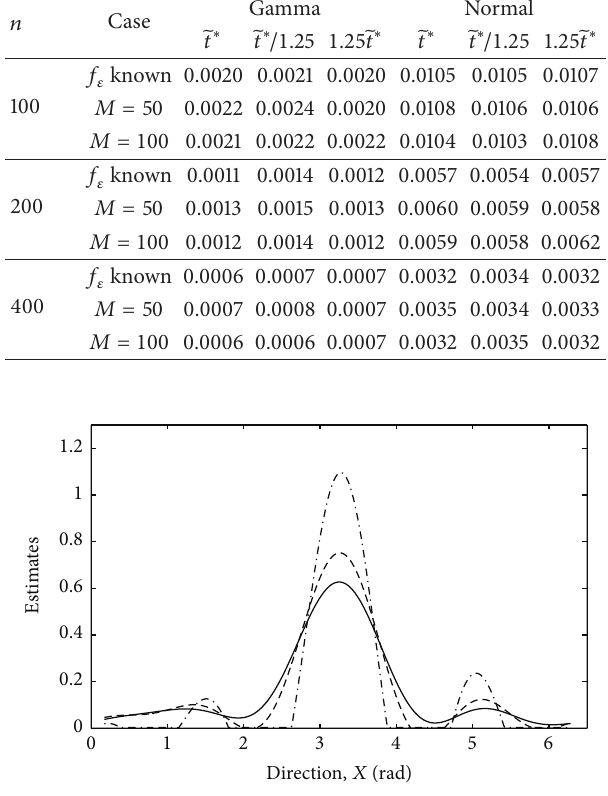
Figure 3: Estimates of density of movement of ants. The solid line is the estimate based on direct data, and the dashed and dot-dashed lines are the estimates under assumption on normal error with zero mean and standard deviations 𝜎 = 0.3 and 𝜎 = 0.5 , respectively.